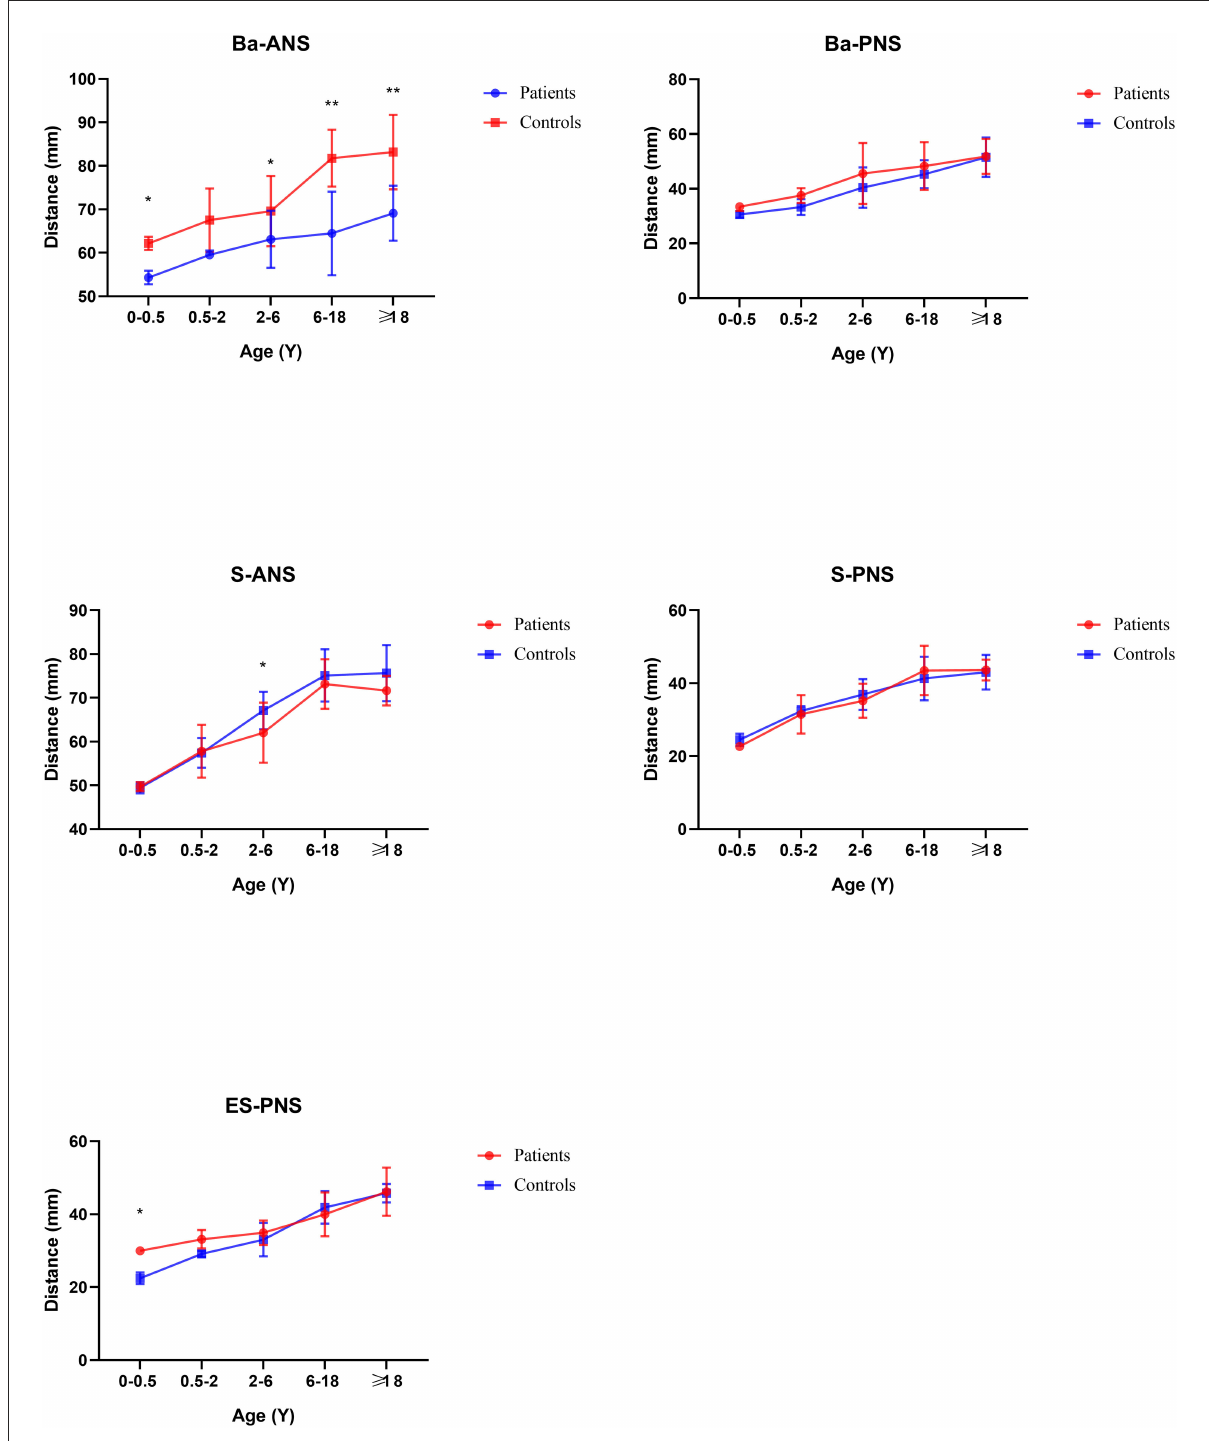
FIGURE7 Angular measurements by subgroup analysis. * P < 0.05; ** P <